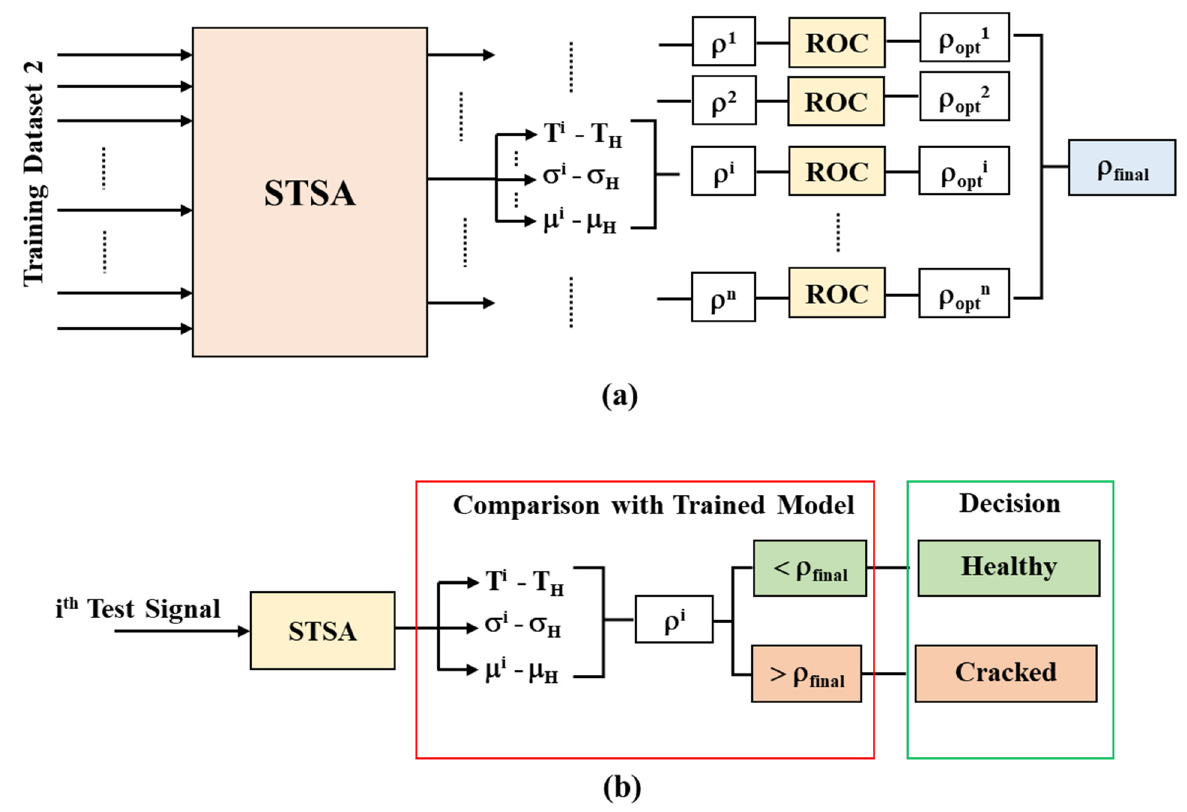
Figure 8. ( a ) Training algorithm for obtaining the optimal threshold; ( b ) Decision-making process for a test signal using the trained STSA model.